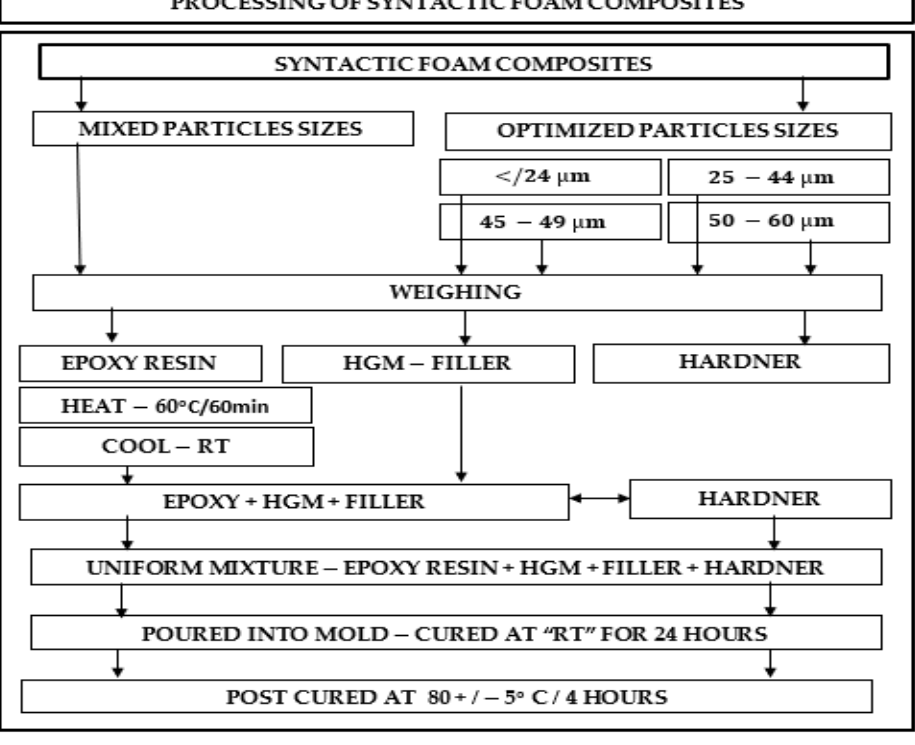
Figure 1. Schematics representation of the syntactic foam formation by the combination of hollow glass microspheres with the epoxy